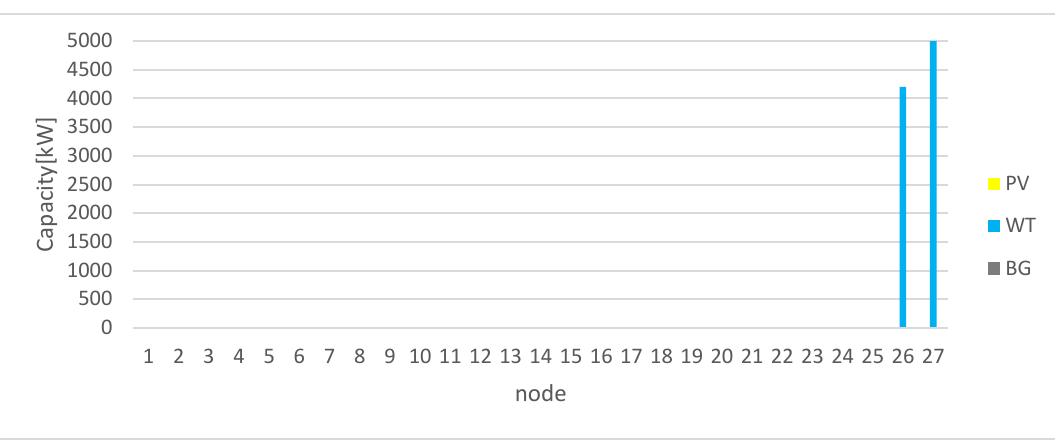
Figure A6. Capacity structure for scenario “4”.